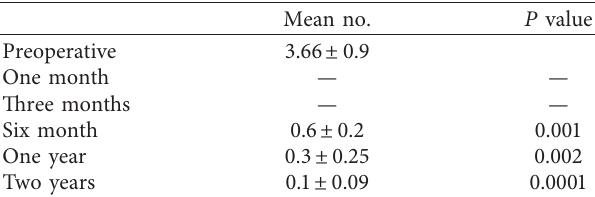
Table 5: The mean number of antiglaucoma medications.